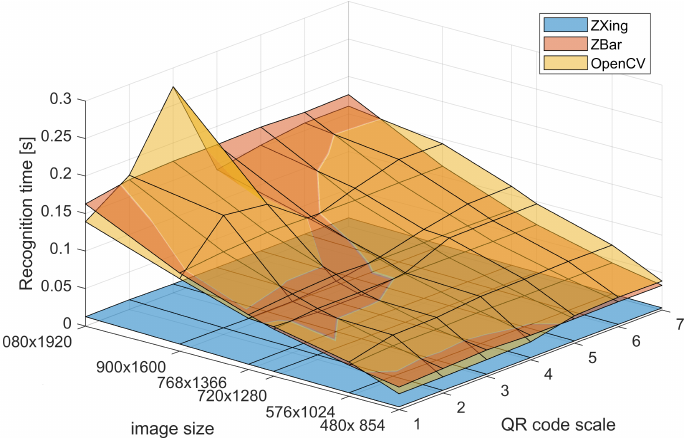
Figure 14. Recognition time for detect-and-decode of QR code in images of various